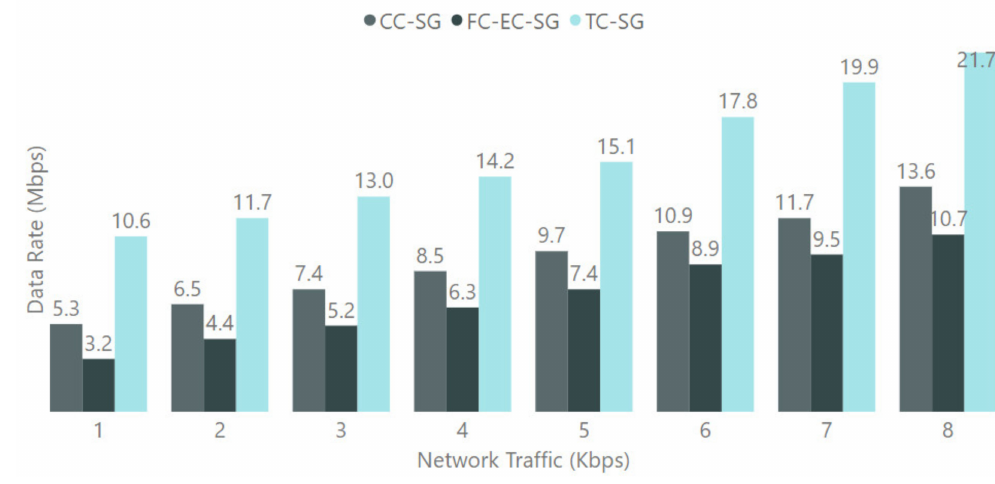
Figure 8. Network tra ffi c in CC-SG, FC-EC-SG, and TC-SG.